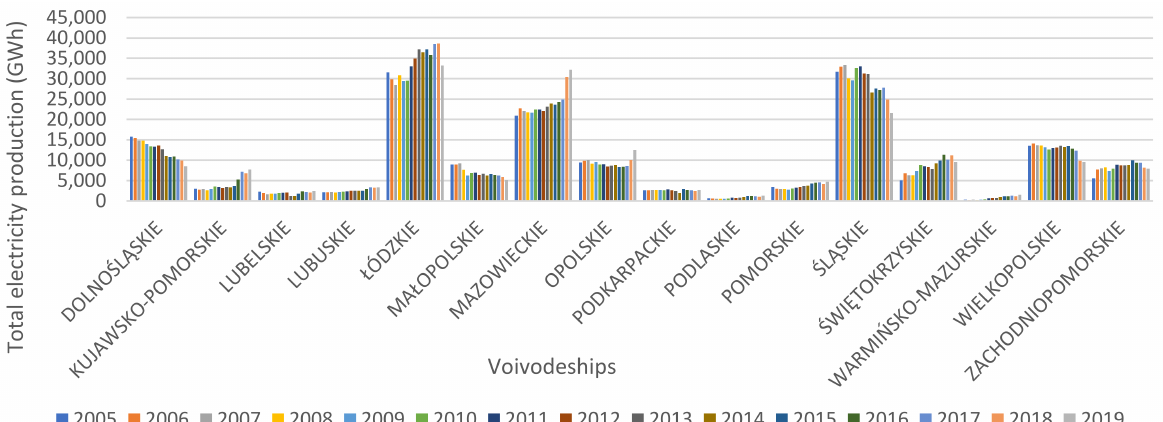
Figure A4. Total electricity production in individual Polish voivodeships in 2005–2019 (GWh). Source: Own calculations based on the LDB.